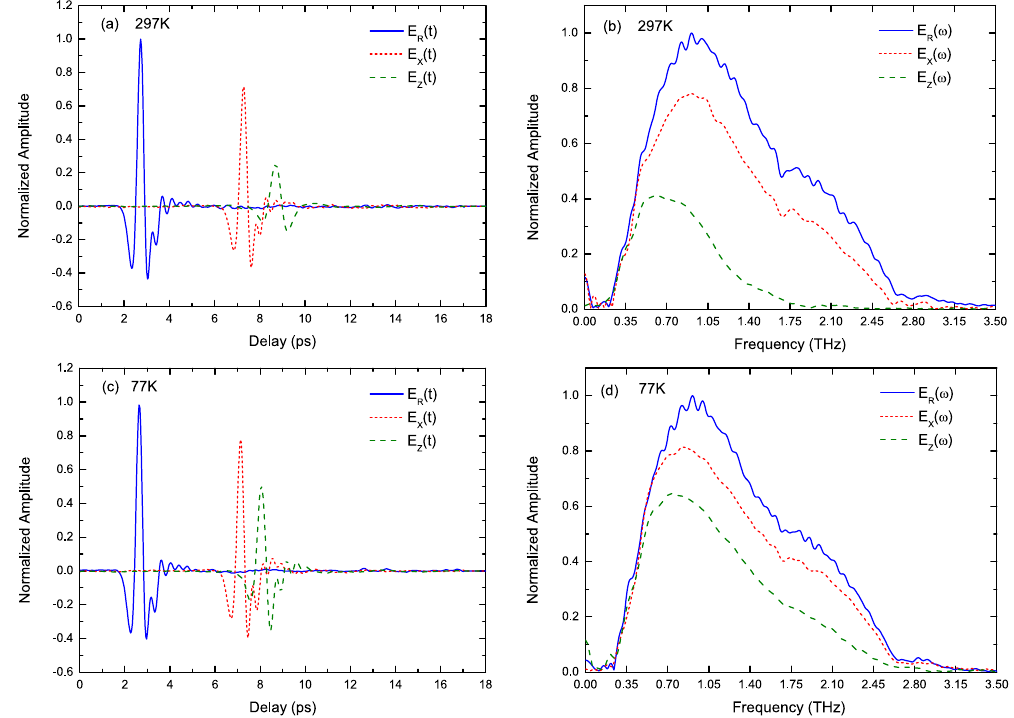
Figure 1. Measured time and frequency domain waveforms of the reference pulse and sample pulse at 297 K and 77 K. The blue solid line, the red short dashed line and the olive dashed line represent reference pulse, sample pulses polarizing along X-axis and Z-axis, respectively. ( a , c ) Temporal waveforms at 297 K and 77 K, respectively. ( b , d ) Spectra in the range of 0 to 3.5 THz at 297 K and 77 K,